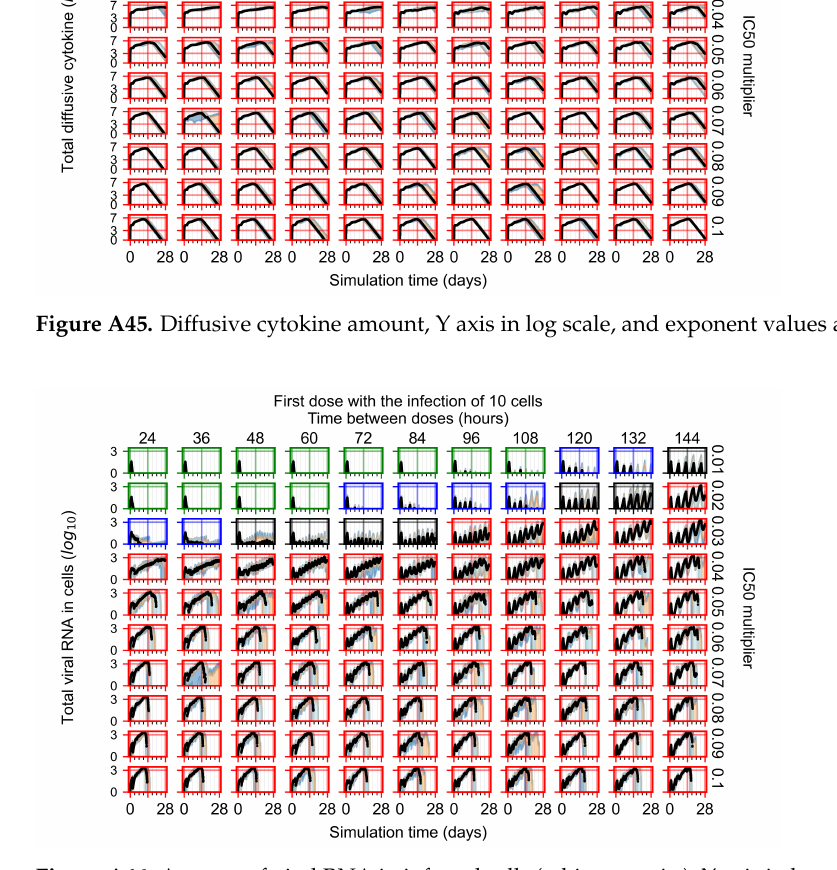
Figure A46. Amount of viral RNA in infected cells (arbitrary units), Y axis in log scale, and exponent values as tick